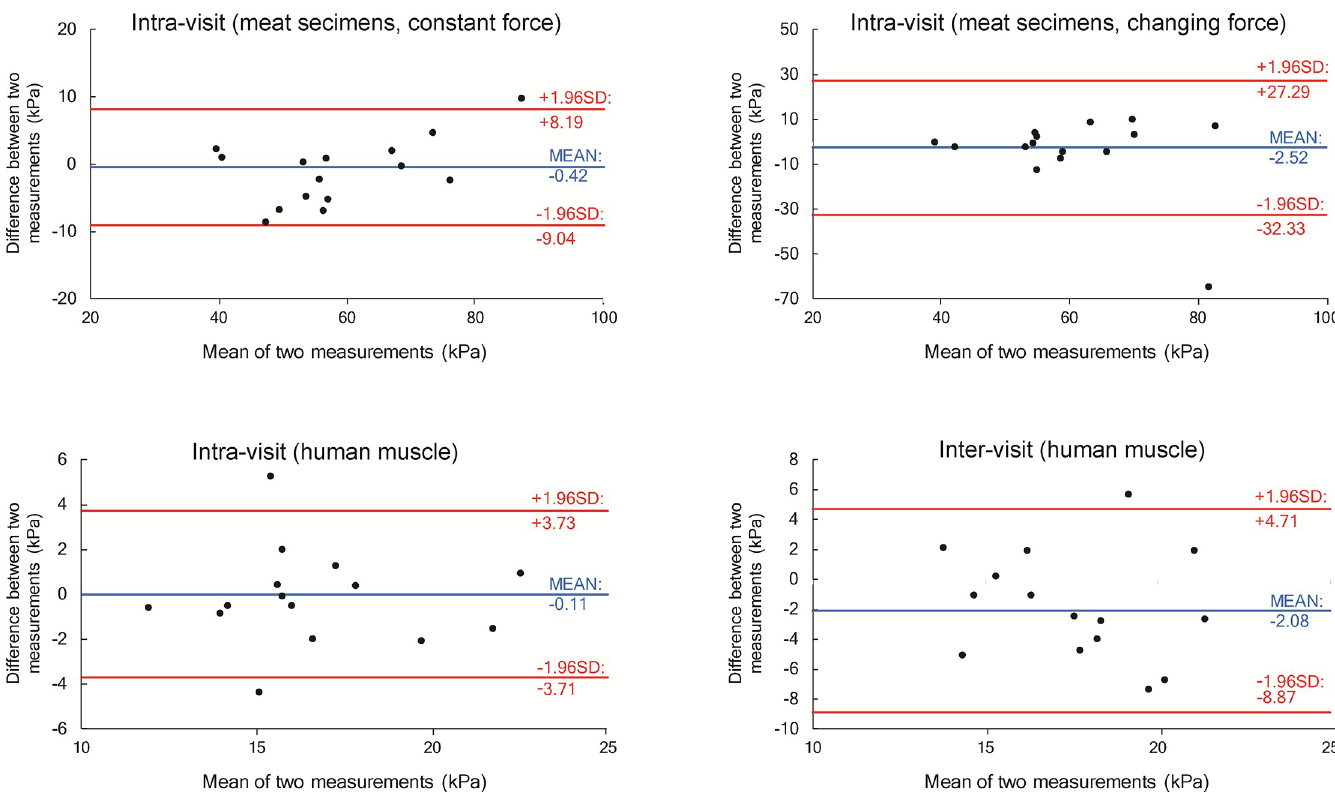
Fig 5. Bland-Altman plots of measurements conducted with custom-made device. Horizontal lines indicate the mean difference between measurements (blue) and 95% confidence intervals (red).